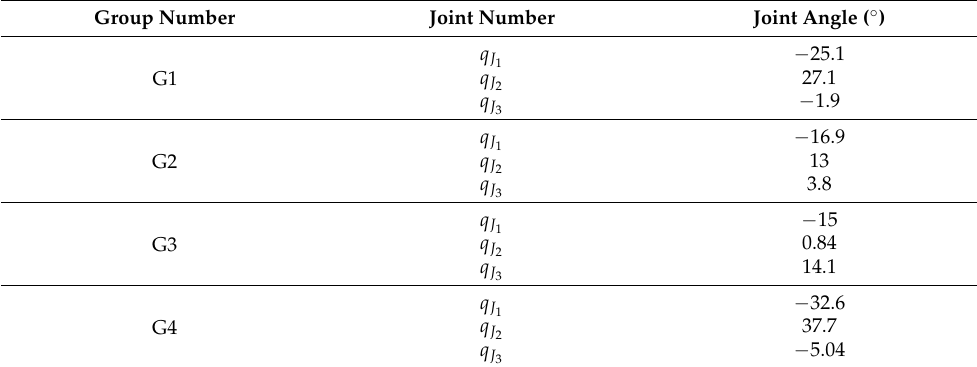
Table 1. The joint configurations of different groups.